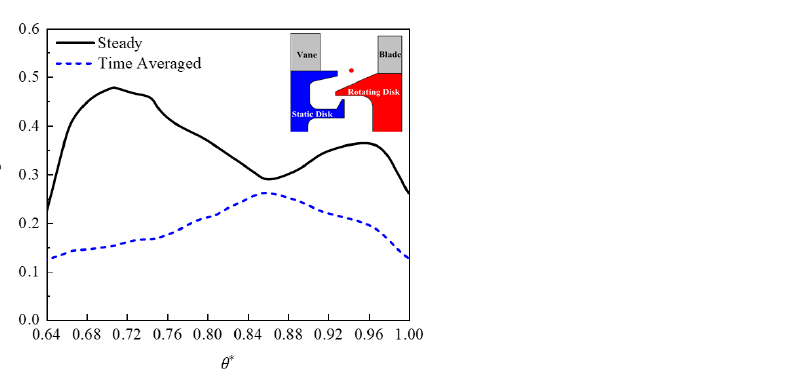
Figure 11. Radial velocity contour distributions at the clearance outlet and static pressure coefficient distributions at the endwall (Seal-A and IF = 0.6%). ( a ) (74 + 1/4) T ; ( b ) (74 + 1/2) T ; ( c ) (74 + 3/4) T ; ( d ) (74 + 1) T .